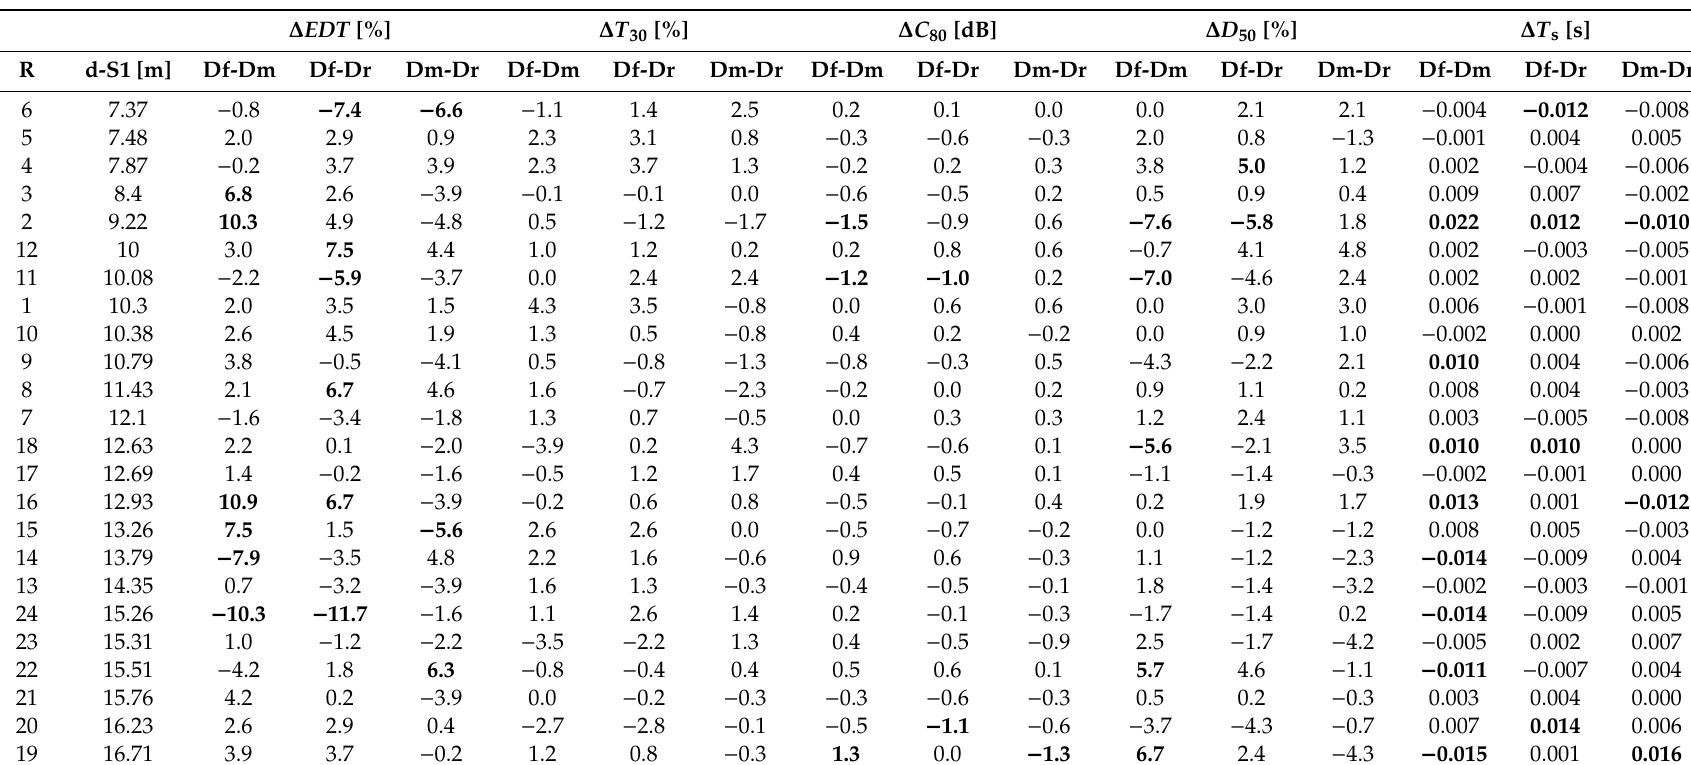
Table A1. Objective acoustic parameter di ff erences between the configurations with di ff erent di ff user locations in the reflective (-R) condition for S1. Di ff erences equal or higher than the JNDs of the parameters are given in bold